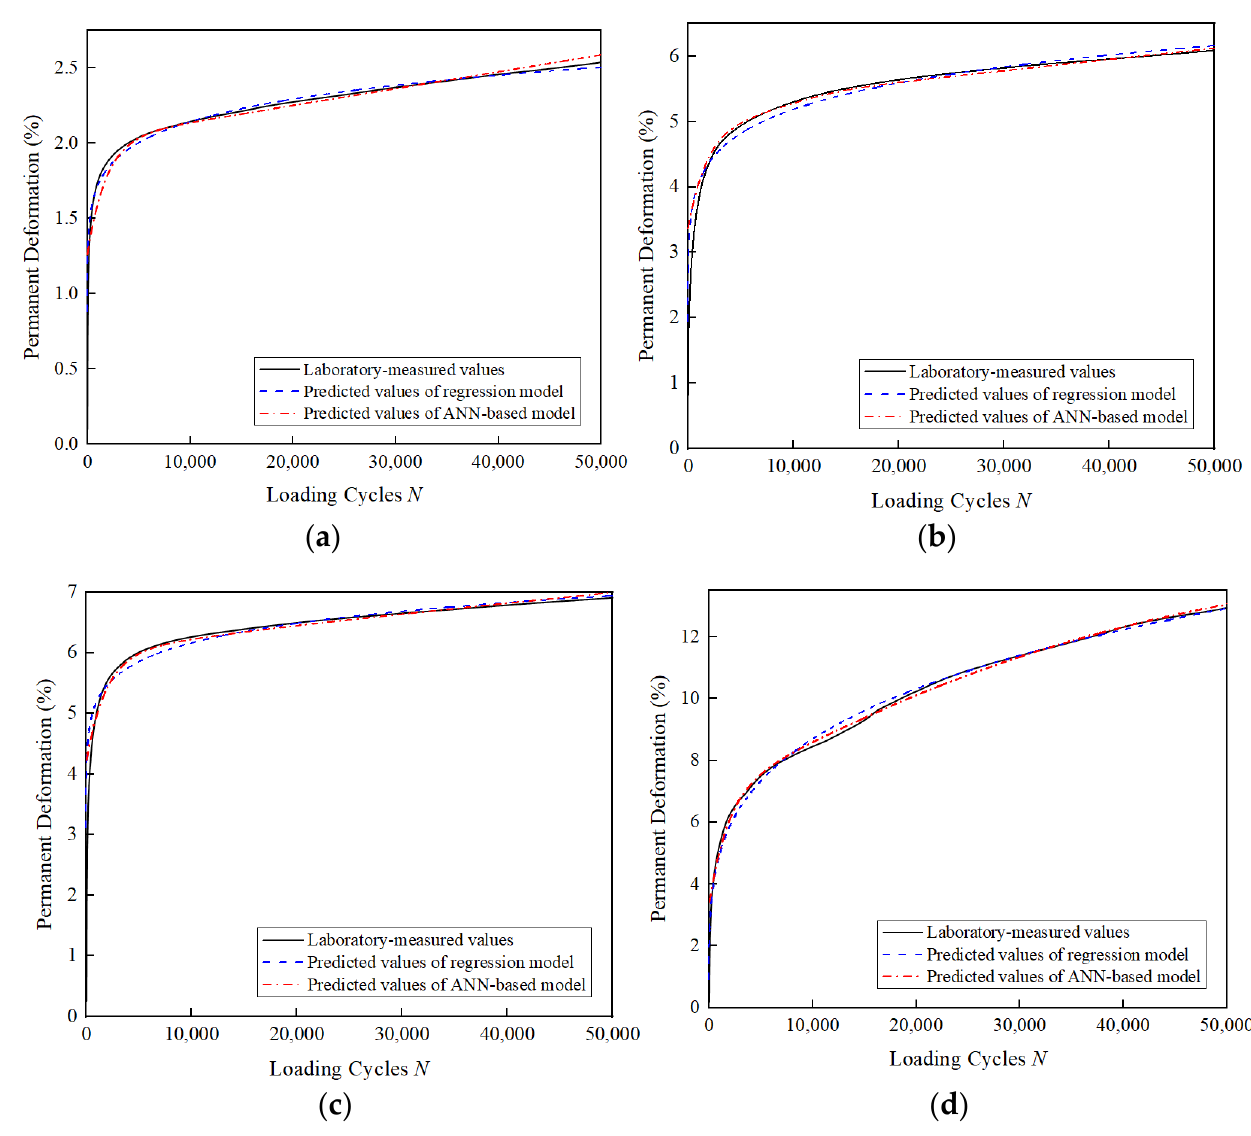
Figure 16. Comparison between the predicted and measured permanent deformation: ( a ) G / S = 2.5, σ 3 = 50 kPa, SSR = 0.7; ( b ) G / S = 2.5, σ 3 = 50 kPa, SSR = 0.9; ( c ) G / S = 2.5, σ 3 = 150 kPa, SSR = 0.7; ( d ) G / S = 2.5, σ 3 = 150 kPa, SSR =